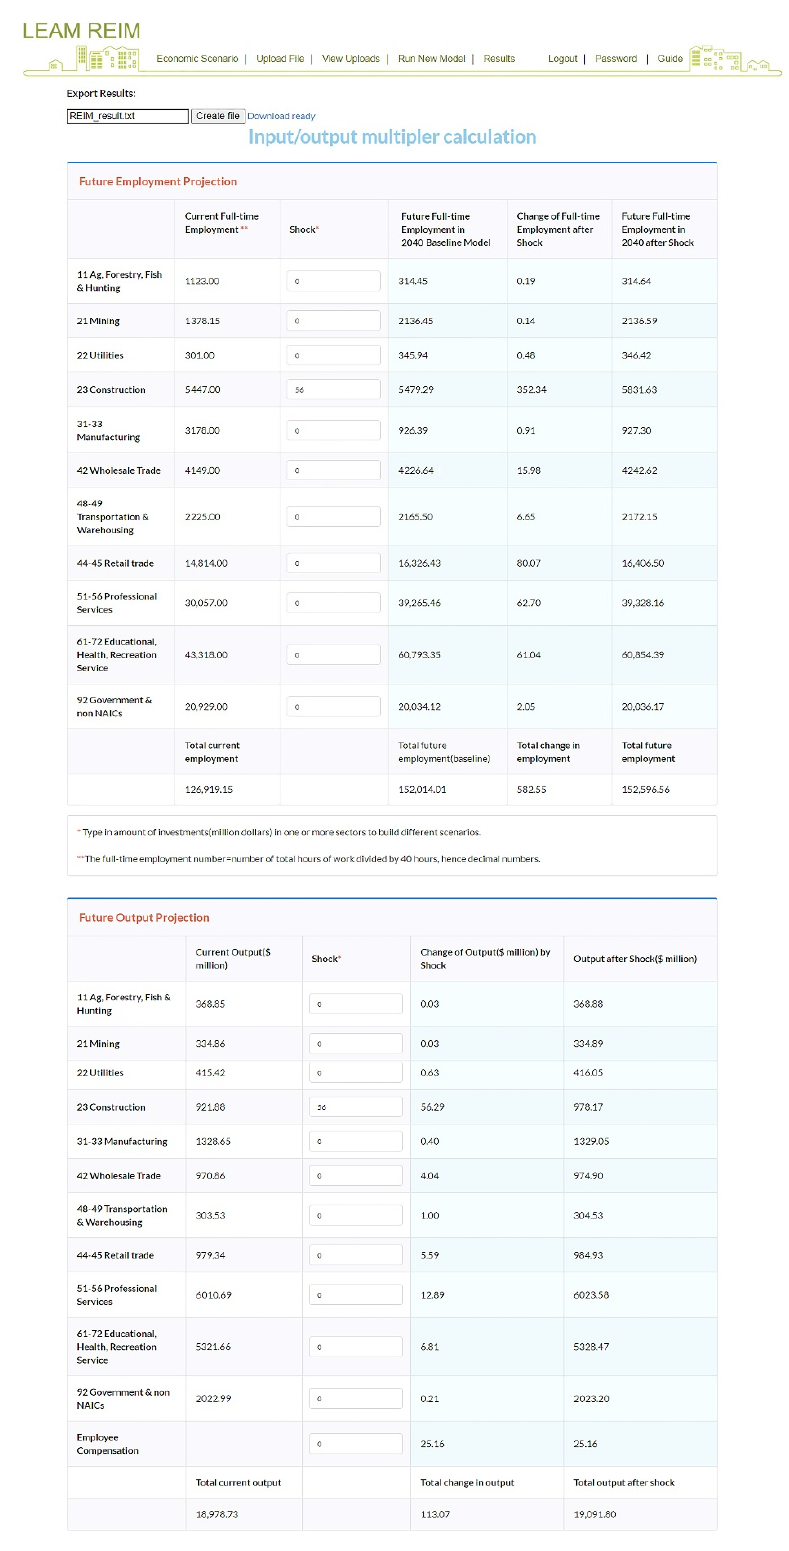
Figure 6. LEAM-REIM interface showing REIM result of the investment plan which invested 56 million dollars in construction. The investment is described as “Shock” values for each industry type for the current year (in millions of dollars). “Future Full-time Employment in 2040 in baseline model” shows the estimated employment in 2040 if without any investment. “Future Full-time Employment in 2040 after shock” shows the estimated employment in 2040 considering the investment